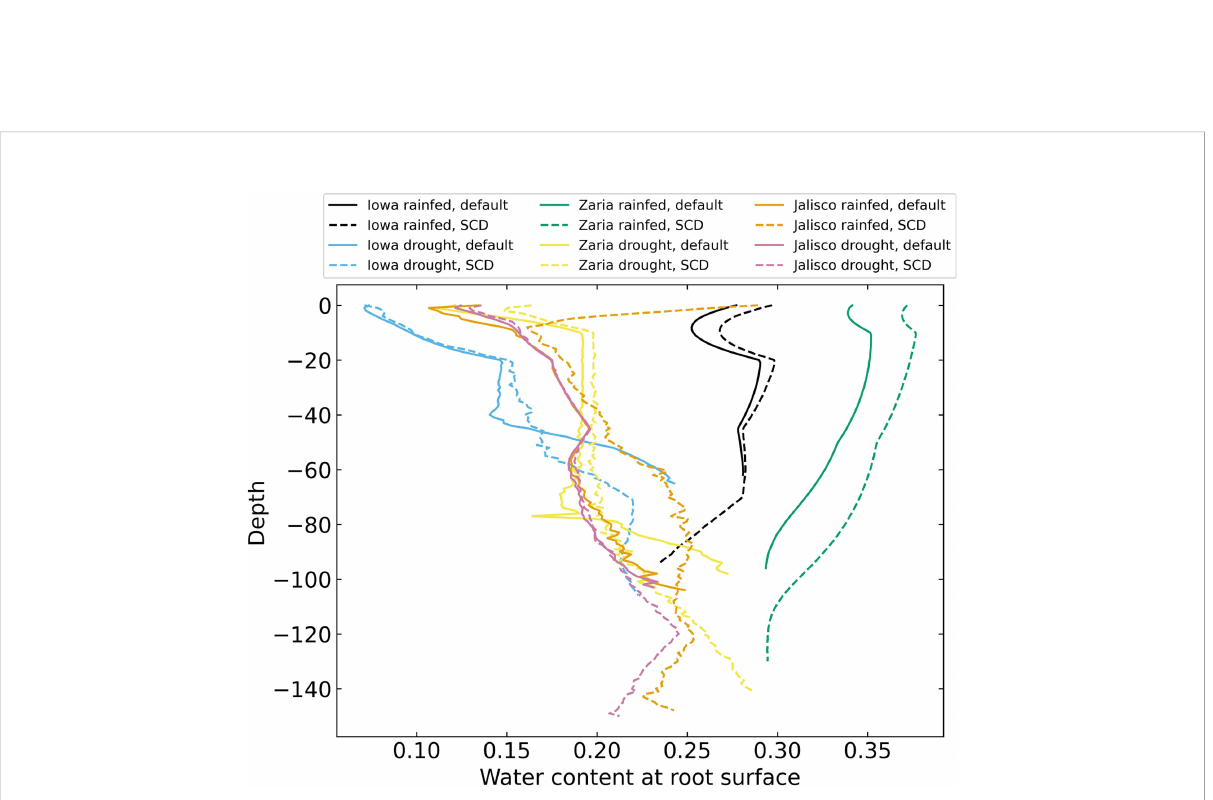
FIGURE 8 Volumetric water content near the roots on day 42 for 12 individual simulations, averaged over 1 cm layers.